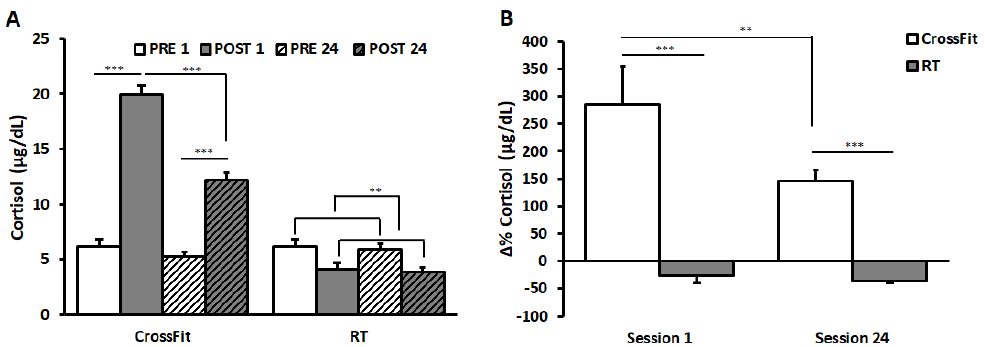
Figure 2. Cortisol value and ∆% cortisol. Cortisol values (panel ( A )) of CrossFit ® group (left) and RT group (right), before (PRE) and after (POST) the first training session (PRE 1, POST 1) and the last training session (PRE 24, POST 24). ∆% Cortisol (panel ( B )) of CrossFit ® group (left) and RT group (right) after the first training session (SESSION 1) and the last training session (SESSION 24). Data are presented as means ± standard error. ** p < 0.01; *** p < 0.0001.